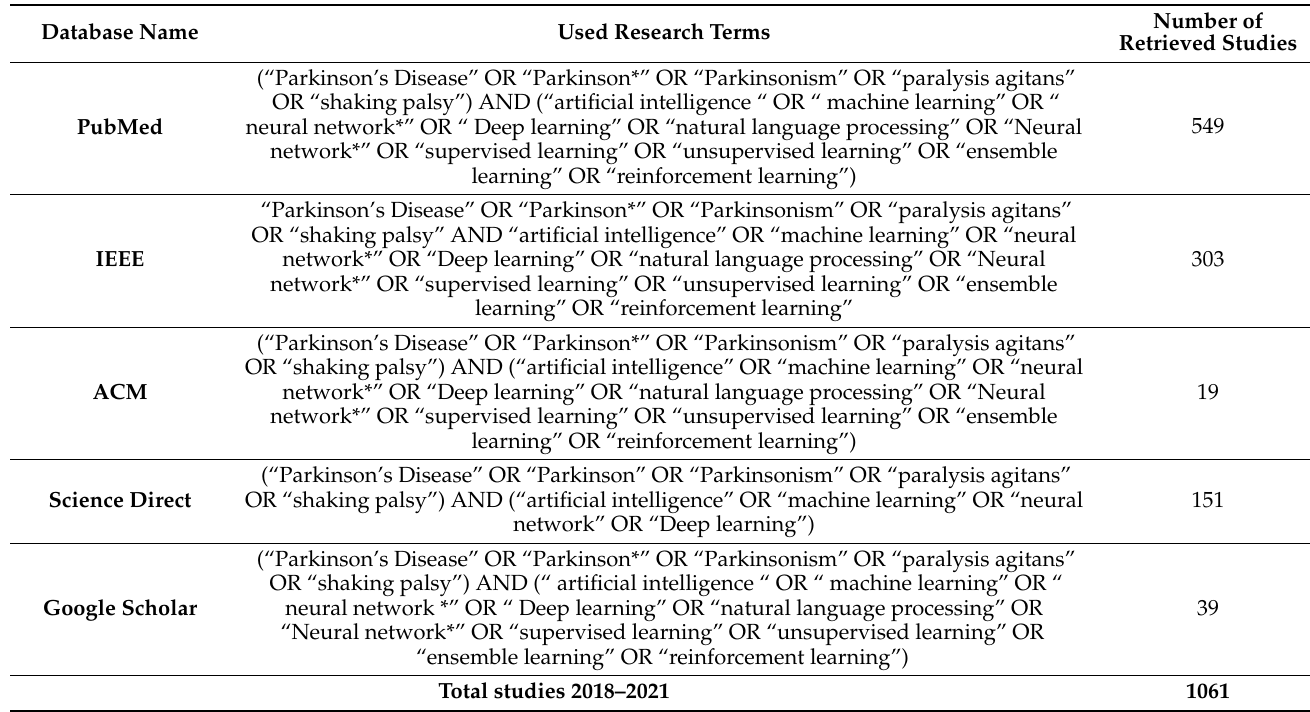
Table A1. Used search terms and total number of retrieved studies per